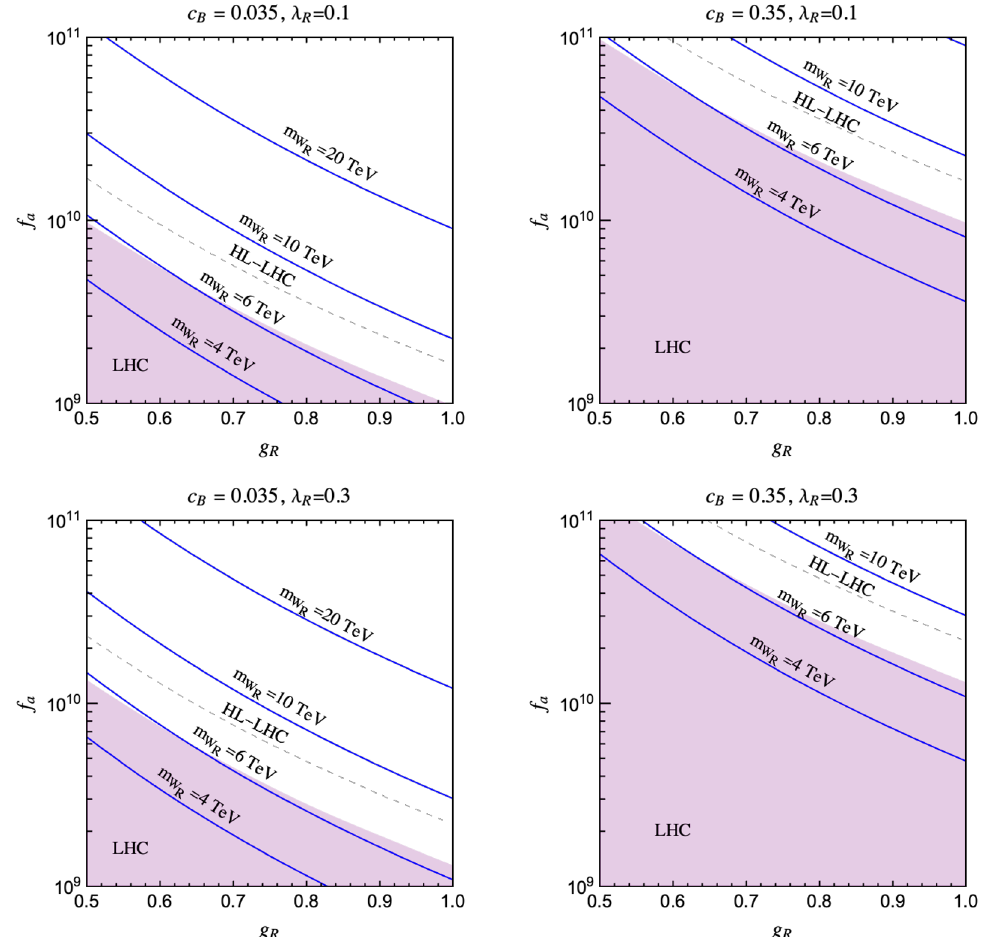
in the ( f ) plane for c = 0 . 035 and 0 . 35 . The pink-shaded a , g R B R